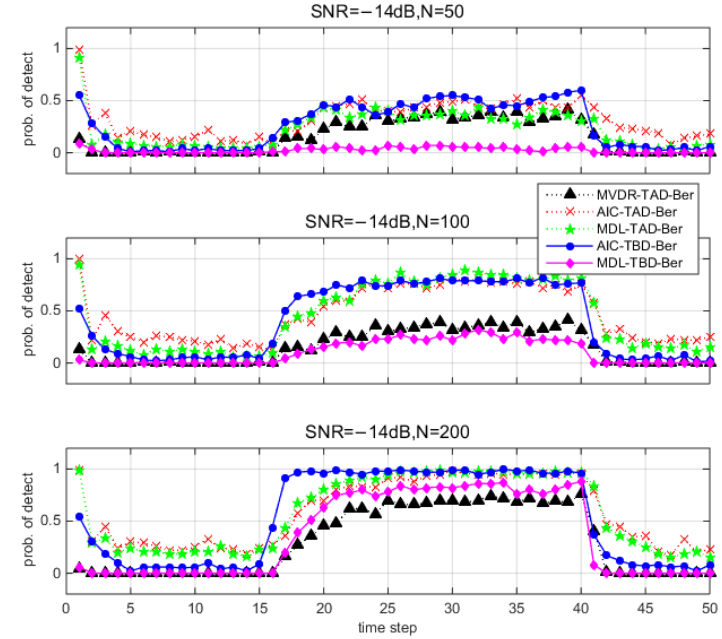
Figure 7. Detection performance for different methods (100 Monte Carlo runs) when SNR = −14 dB and number of snapshots 𝑁 = 50, 100, 200 .